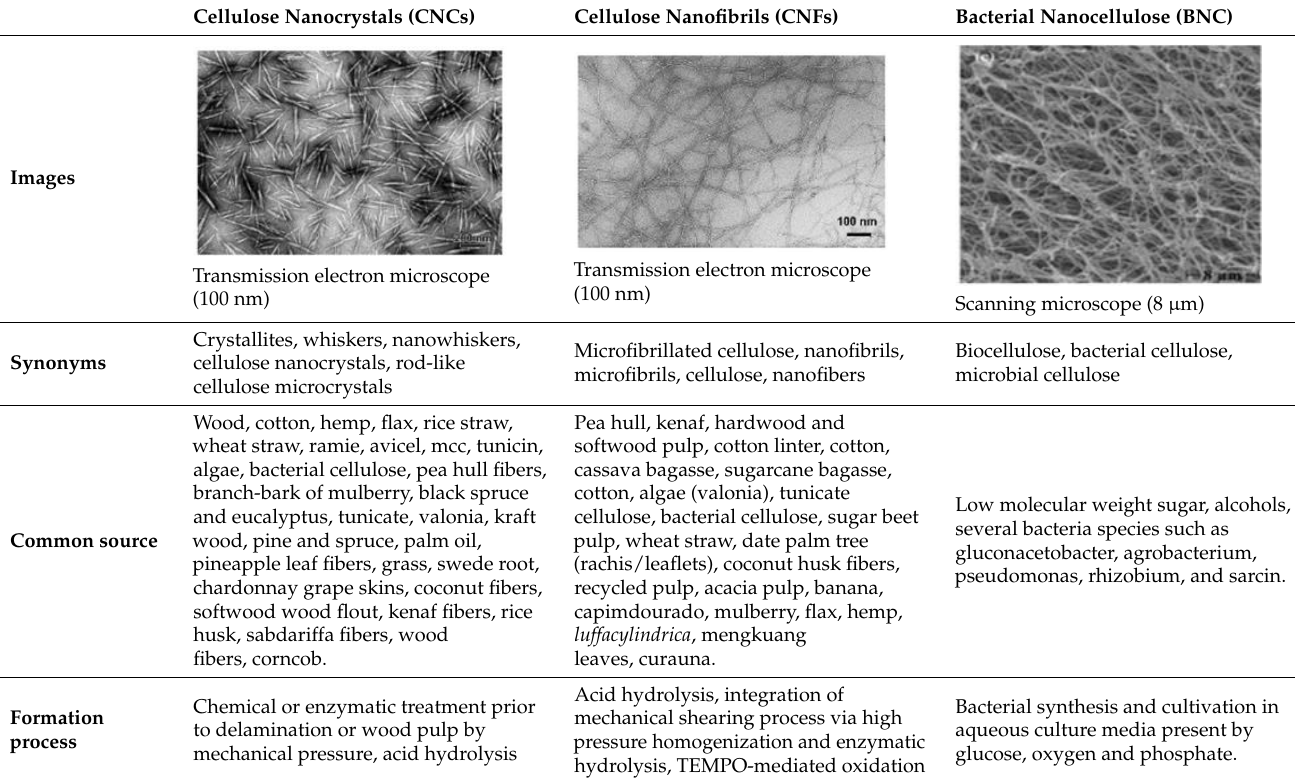
Table 2. Comparison between the different types of nanocellulose [29].